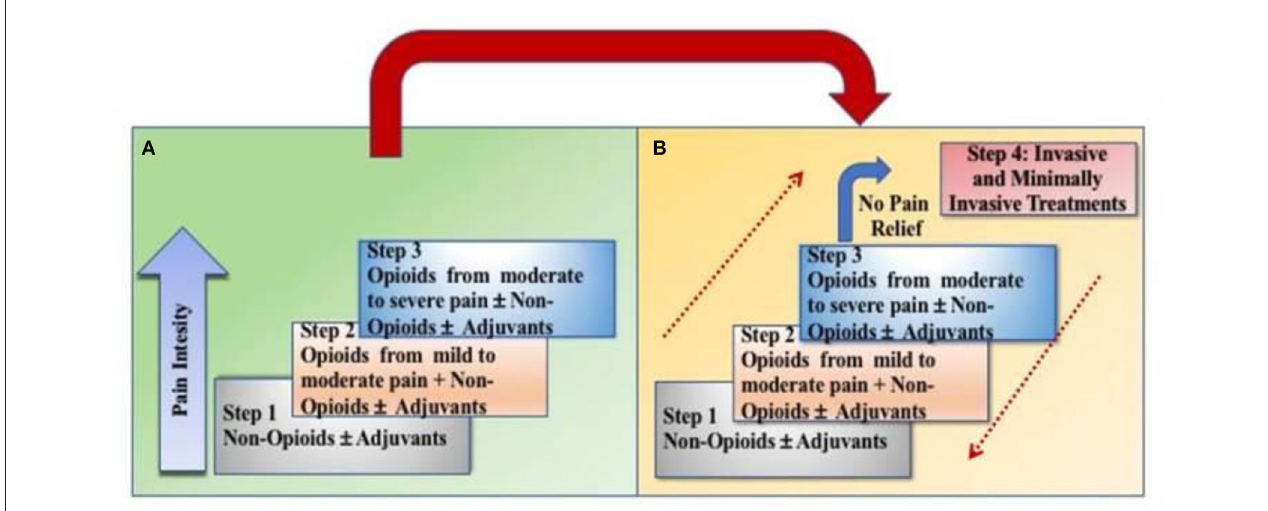
FIGURE 2 | Transition from the original WHO three-step analgesic ladder (A) to the revised WHO fourth-step form (B) . The additional step 4 is an “interventional” step and includes invasive and minimally invasive techniques. This updated WHO ladder provides a bidirectional approach.